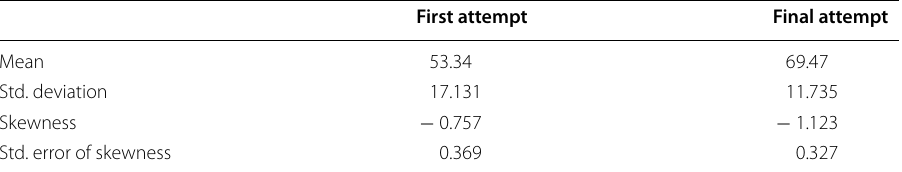
Table 2 Results of gamification attempts First attempt Final attempt Mean 53.34 69.47 Std.